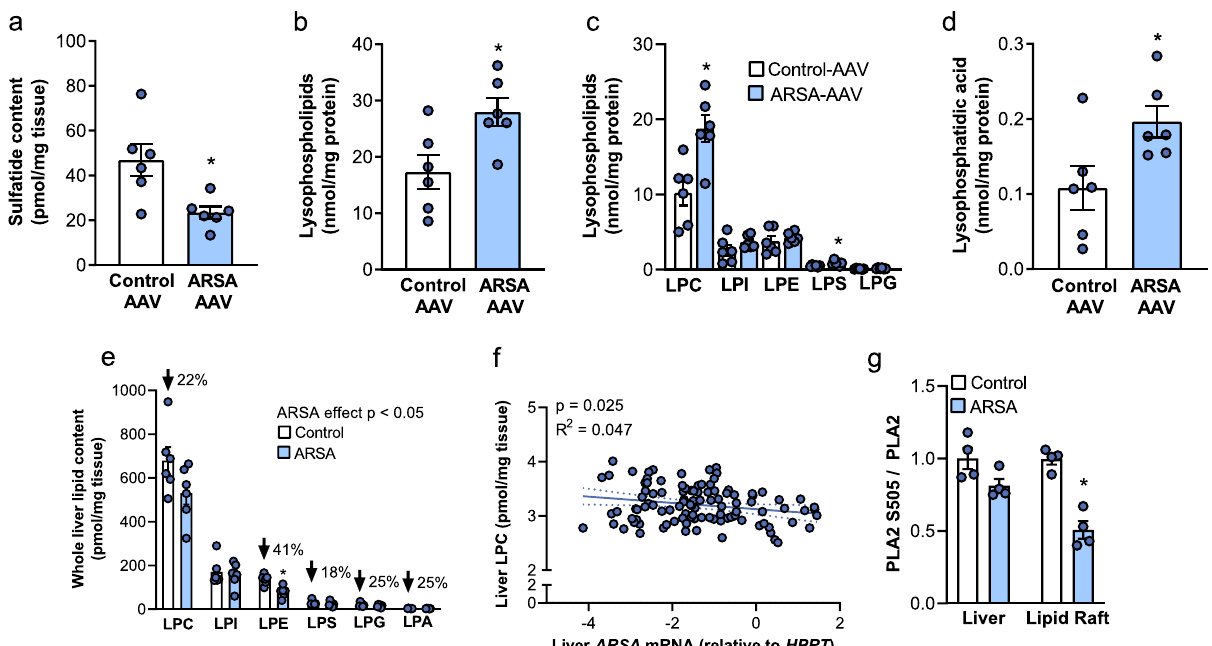
Fig. 6 Hepatic ARSA remodels lipid rafts in the liver. ARSA was overexpressed in the livers of male db/db mice using a liver-speci fi c adeno-associated virus (ARSA-AAV, blue bars) and was compared with Control-AAV (white bars). a Sulfatide content in whole-liver extracts ( n = 6/group), * P = 0.0130. b Lysophospholipid content (* P = 0.0209), c lysophospholipid classes (* P = 0.006 for LPC, * P = 0.0241 for LPS), and d lysophosphatidic acid in liver lipid rafts ( n = 6/group, * P = 0.033). e Lysophospholipid classes in whole-liver extracts ( n = 6/group). ARSA effect * P = 0.0122, * P = 0.002 for LPE. f Correlation of ARSA mRNA expression and lysophosphatidylcholine (LPC) content in human livers ( n = 106). g Phospholipase A2 (PLA2) S505 phosphorylation in whole-liver and liver lipid rafts ( n = 4/group, * P = 0.0001 for LR). Data are means ± SEM. * P < 0.05 vs. Control-AAV, as assessed by two-tailed unpaired t tests or linear regression analysis ( f ). LPA lysophosphatidic acid, LPC lysophosphatidylcholine, LPE lysophosphatidyl ethanolamine, LPG lysophosphatidyl glycerol, LPI lysophosphatidyl inositol, LPS lysophosphatidyl serine, PLA2 phospholipase A2. Source data are provided as a Source Data fi